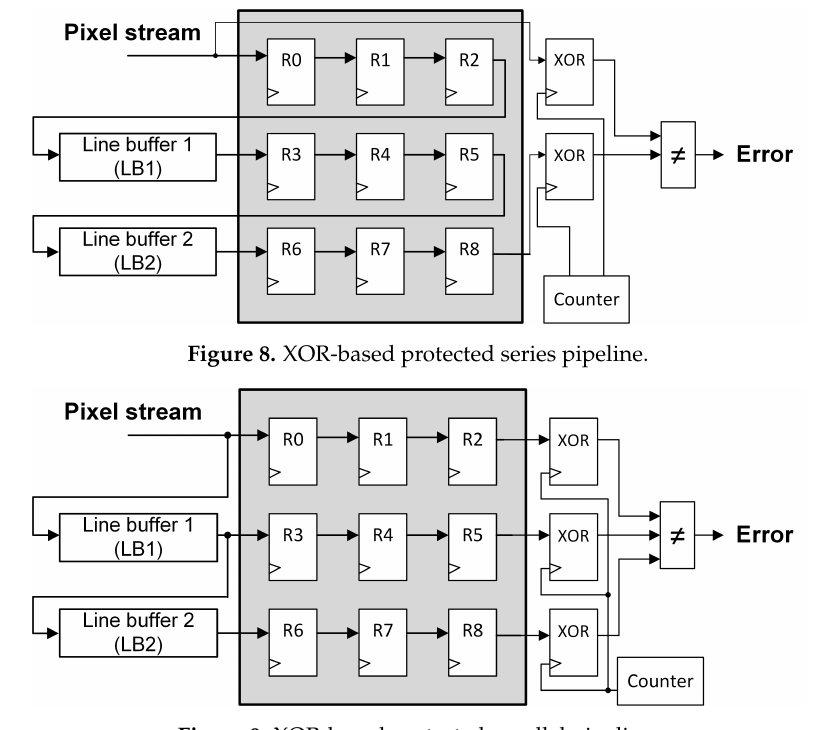
Figure 9. XOR-based protected parallel